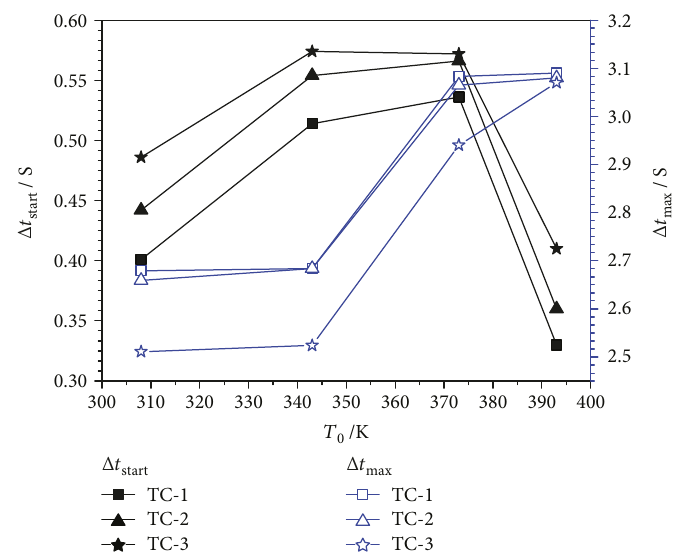
Figure 12: E ff ect of air fl ow temperature on the temperature response time at combustor